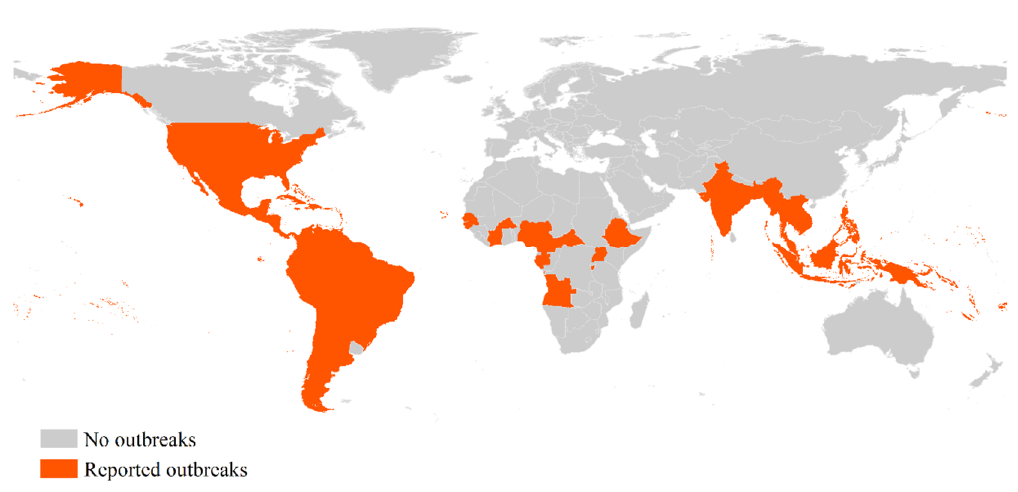
Figure 1. Countries and territories with current or previous Zika virus autochthonous transmission, by the WHO regional office (data as at 2 July 2019).